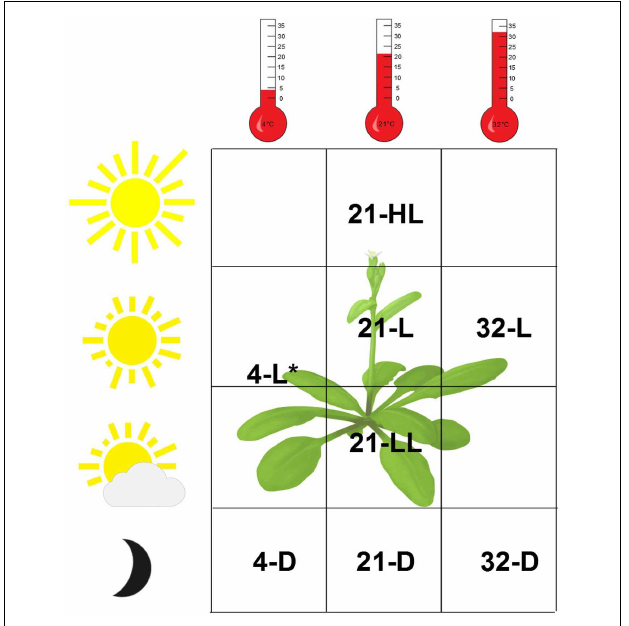
FIGURE 1 | Overview of the experimental conditions of the Arabidopsis thaliana data set. Both light intensity ( D = 0 µ E, LL = 75 µ E,